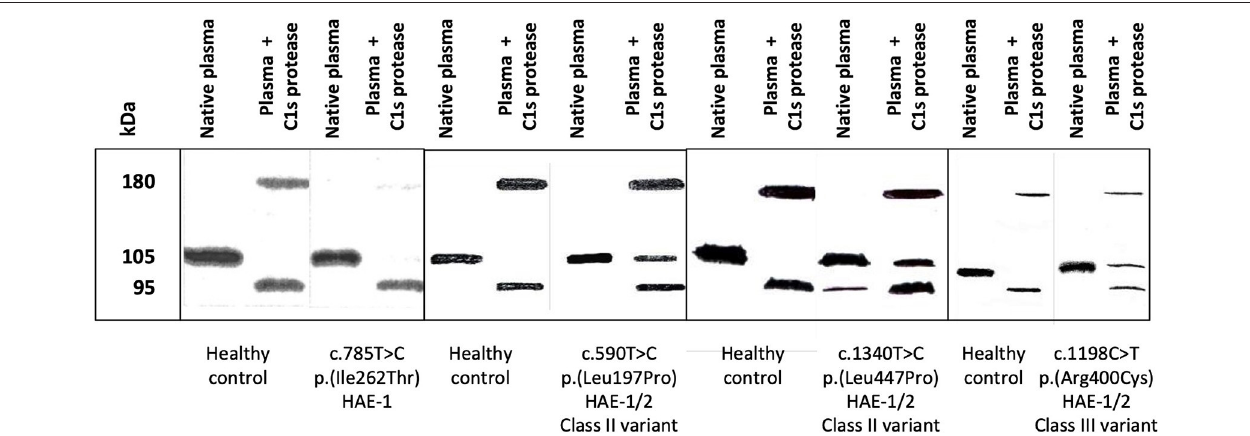
FIGURE 5 | Circulating molecular species were displayed by an anti-C1-INH immunoblot assay. Citrate-plasma samples were collected from patients presenting with hereditary angioedema with C1 Inhibitor deficiency (C1-INH-HAE). Native plasma and plasma submitted to a 15-min incubation at 37 ◦ C with 0.1nM C1s protease (plasma + C1s protease) were analyzed as described in ( 20). Four assays are displayed corresponding to healthy controls and patients with C1-INH-HAE: one type-I HAE (HAE-1) variant and three HAE-1/-2 variants, distributed in classes II and III. HAE-1/-2, C1-INH-HAE satisfying Rosen’s criterion ( 18), with the expression of both alleles and presenting with a low antigenic C1-INH. C1-INH, C1